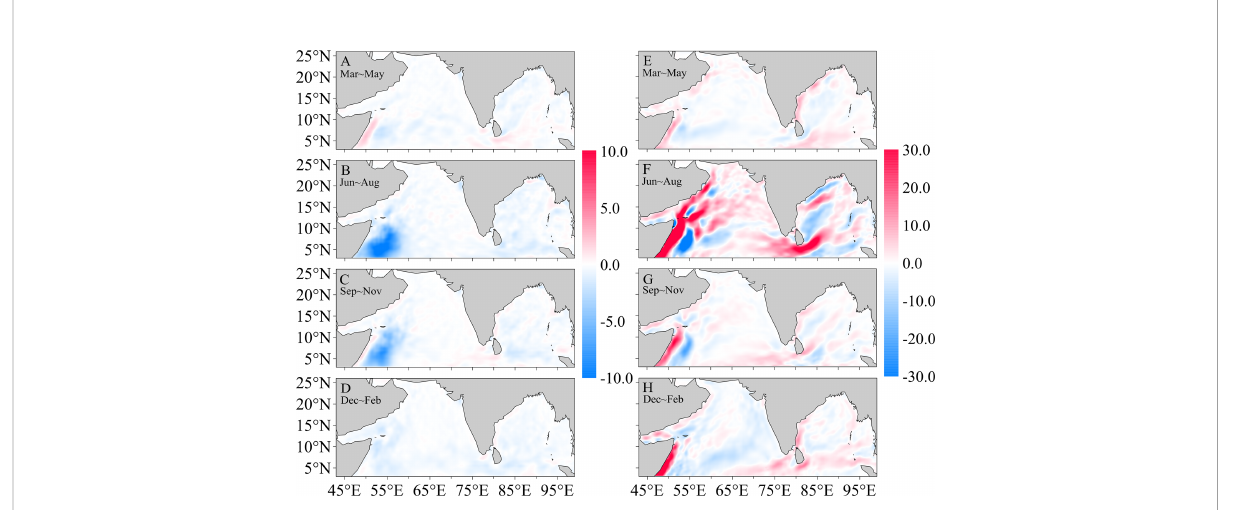
FIGURE 11 Seasonal distribution of WW eg (A-D) and WW mg (E-H) averaged from the surface to 200 m in spring, summer, autumn, and winter (unit: 10 -6 m 3 ·s -3